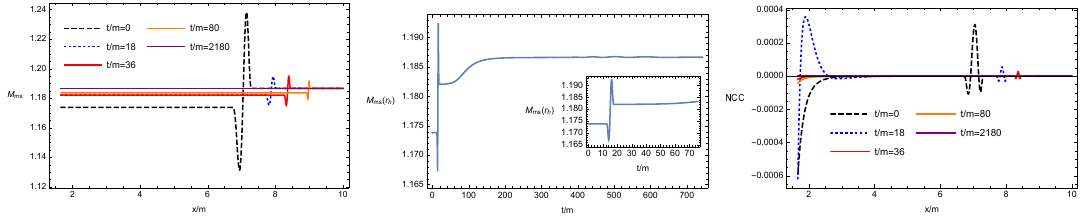
Figure 10 . The evolution of MS mass M MS and the scalar f = R µν l µ l ν . Left: the MS mass as a function of x/m , evaluated at different time instants. Middle: the MS mass as a function of t/m evaluated at the horizon. Right: the scalar f = R µν l µ l ν as a function of x/m , evaluated at different time